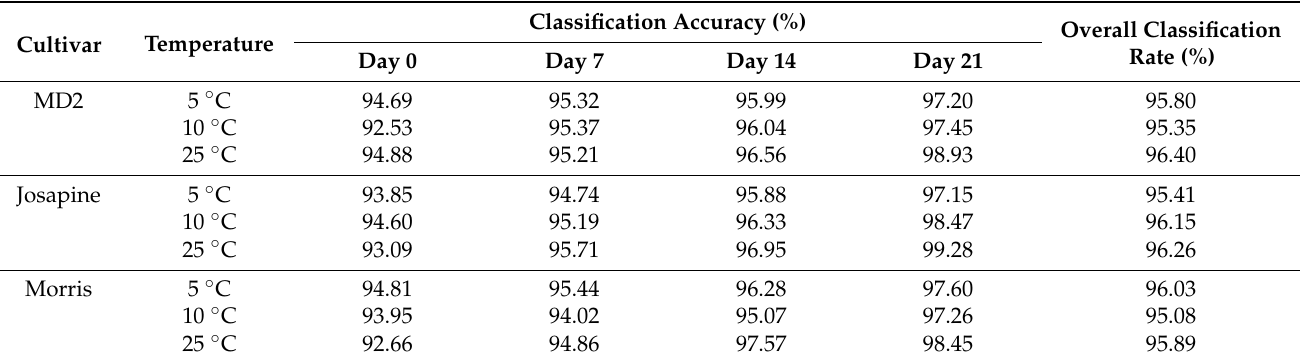
Table 3. Classification performance of pineapple cultivars at different storage days and temperatures using quadratic discriminant analysis.